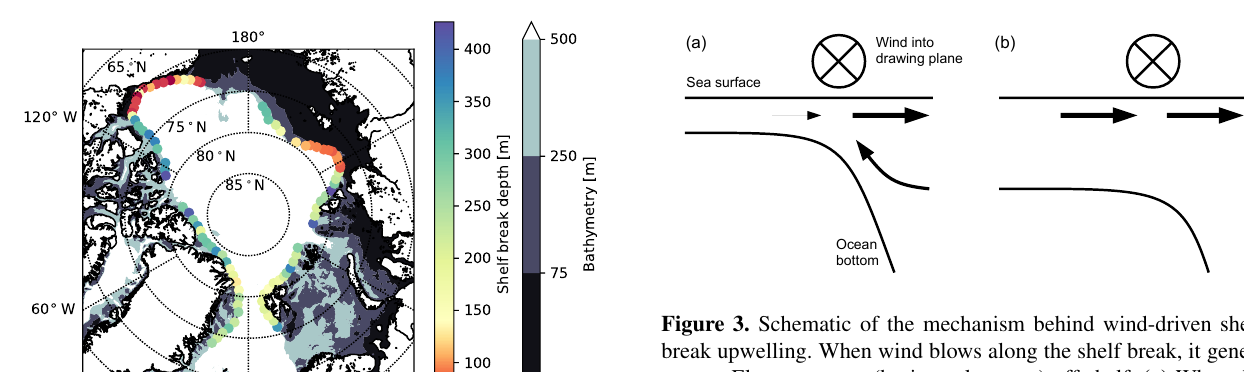
water masses meeting, and the narrow but strong gradient is